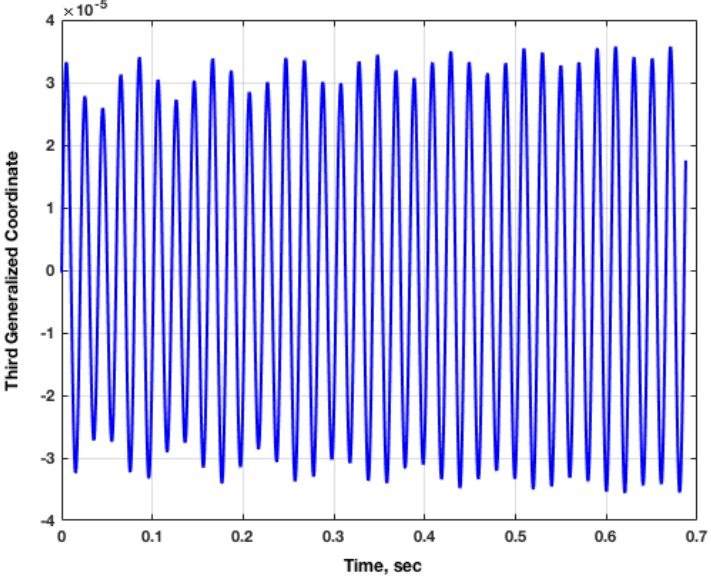
Figure 20. FUN3D full solution third generalized coordinate at M = 1.141, Q = 30 psf, inviscid